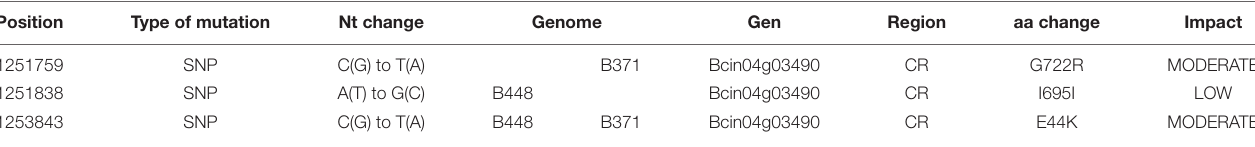
TABLE 2 | Polymorphisms identified in the sequences of the B448 and B371 isolates in comparison with the sequence of the reference isolate B05.10 in the region cloned in plasmid pBAS3 (between nucleotide positions 1.251.101 and 1.254.541 from Chr4). Position Nt change Genome Gen